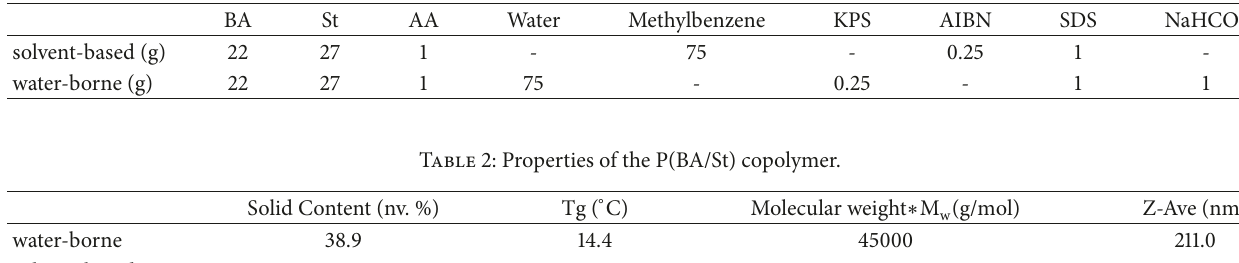
Table 1: The formulae of the solvent-based and water-borne P(BA/St) copolymers.